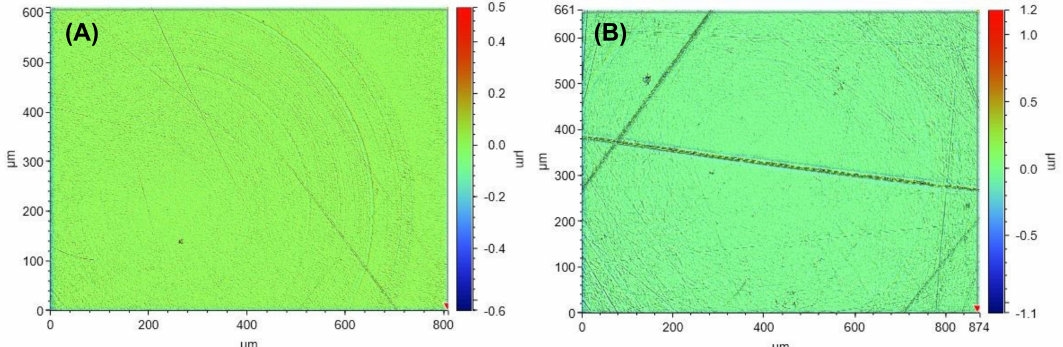
Figure 3. White light interferometer images from a male mould before ( A ) and after significant UV exposure and repeated use ( B ). The coloured legend indicates the height of the roughness in µ m.